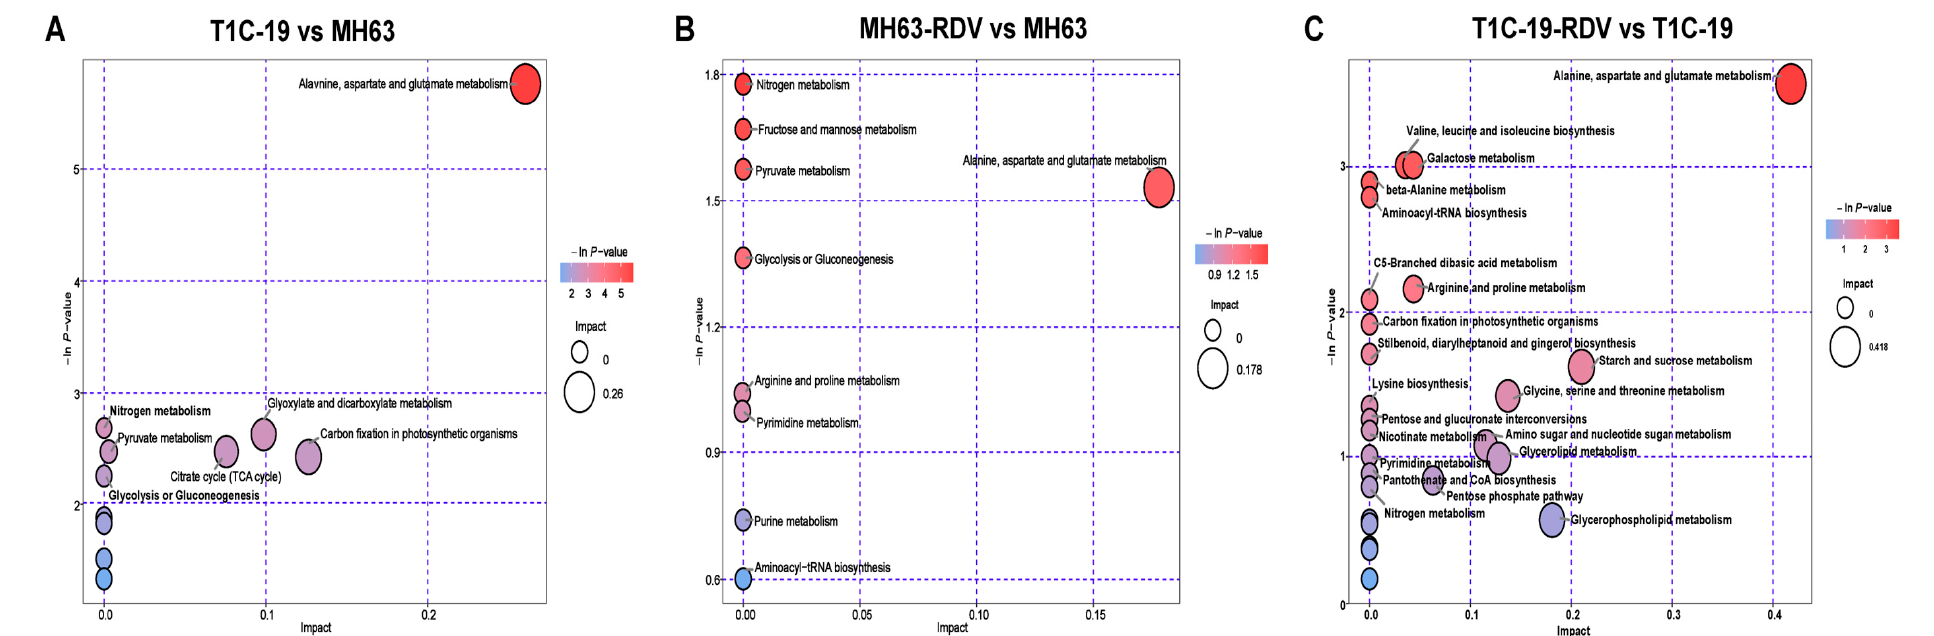
Figure 4. Pathway enrichment of the significantly changed metabolites. Pathway enrichment of the changed metabolites between T1C-19 and MH63 ( A ), between MH63-RDV and MH63 ( B ), and between T1C-19-RDV and T1C-19 ( C ). The abscissa represents the impact of the path topological analysis, and the ordinate is the negative logarithm of p -value of the pathway enrichment analysis. The bigger the bubble, the bigger the impact is; the deeper the color, the larger the value of − ln ( p ), indicates the more significant the enrichment.